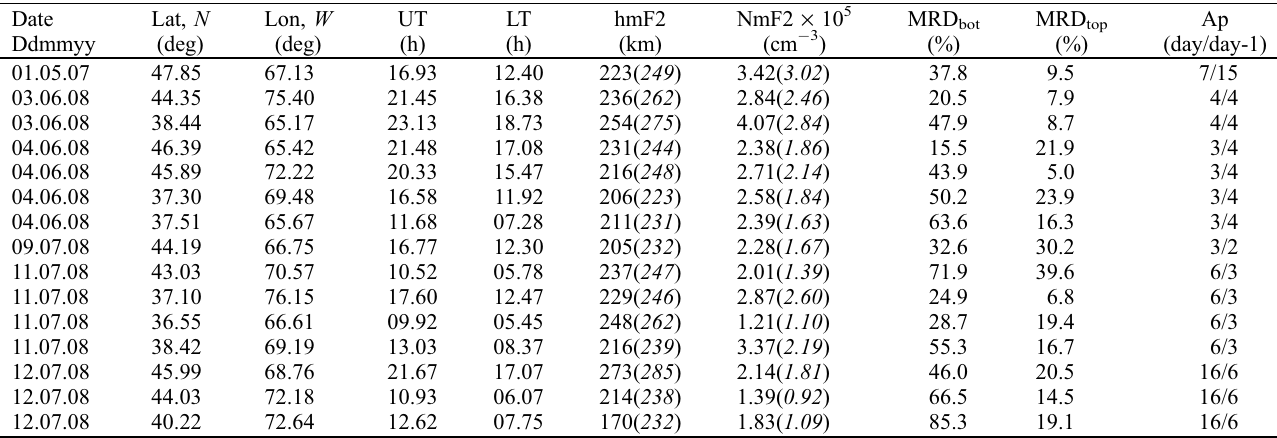
Table 1. Dates of simultaneous Millstone Hill ISR/COSMIC IRO observations for summer months. The coordinates of tangent points, UT and LT of measurements as well as the observed hmF2 and NmF2 values (italic – ISR values) are given. Mean relative deviations are shown when the topside and bottom side of Ne(h) are compared. Daily Ap indices for the current and previous days are